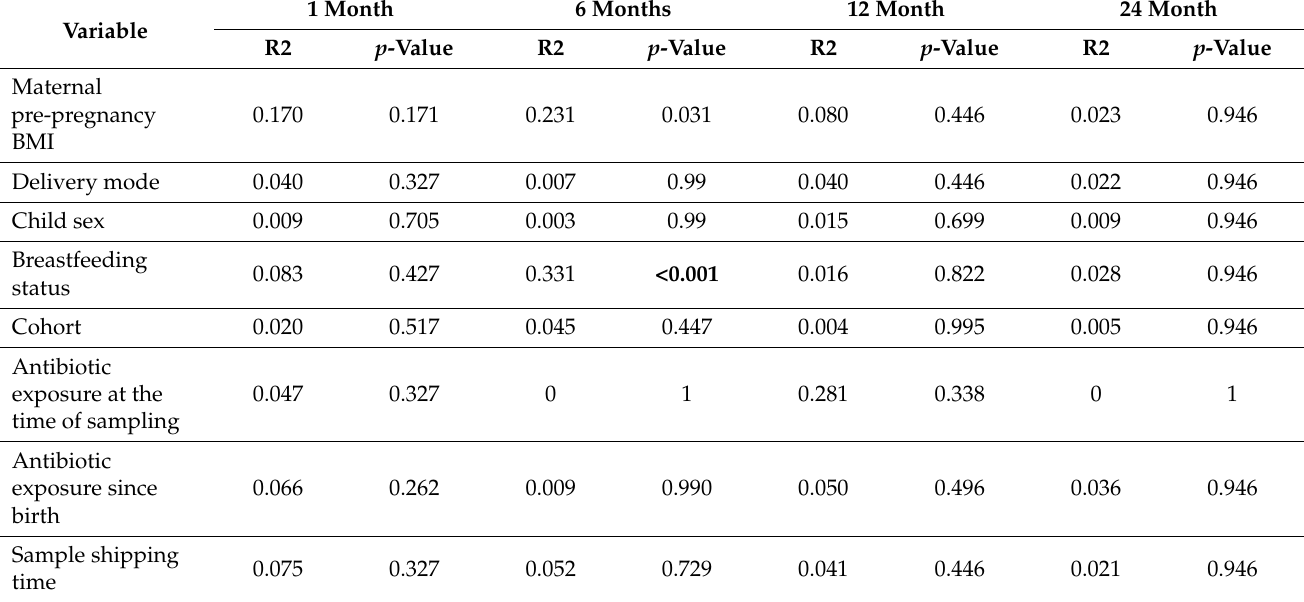
Table 2. Correlation between selected variables and the gut bacterial community beta